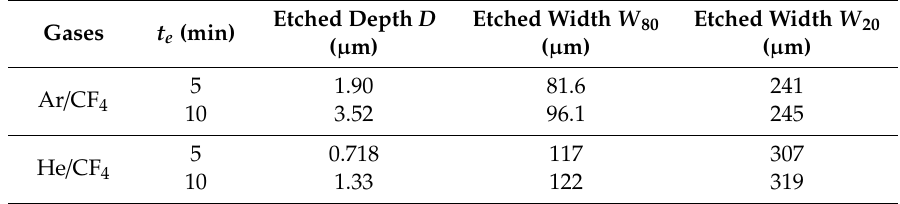
Table 1. Depth and width of grooves obtained with He:CF 4 = 700:300 sccm and Ar:CF 4 = 700:300 sccm at V pp = 9.8